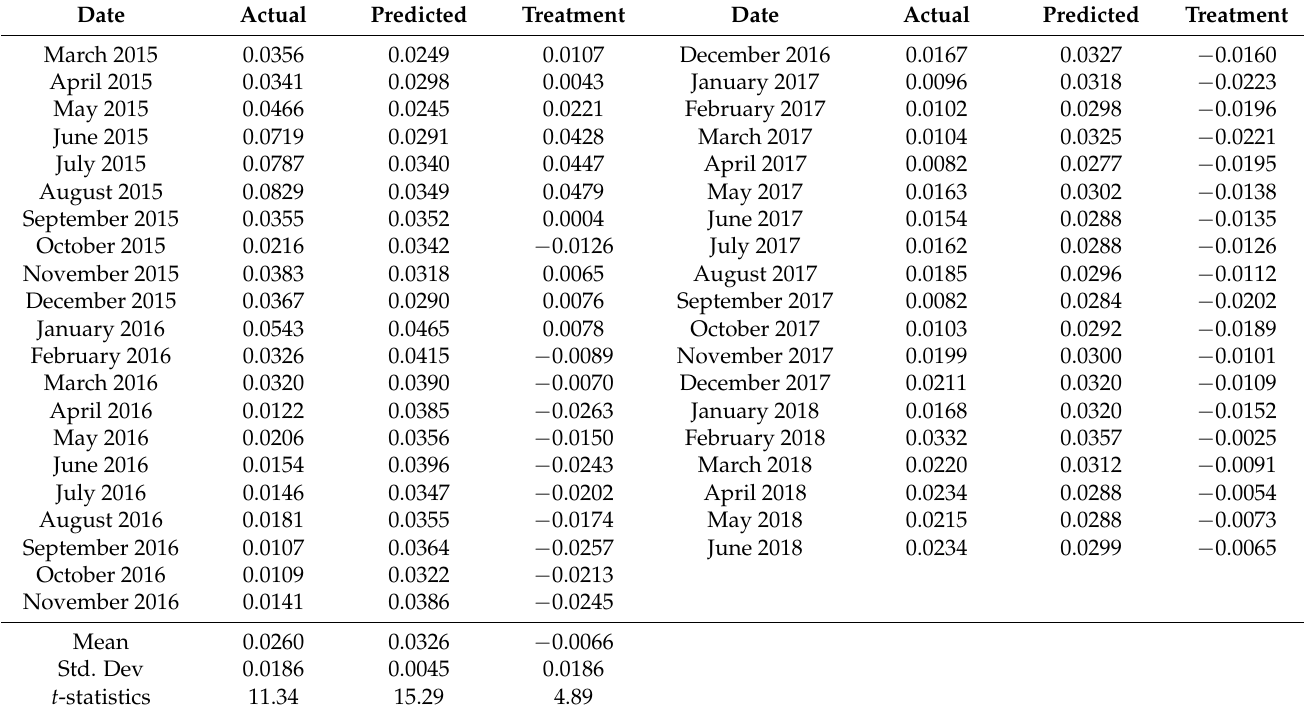
Table 3. Monthly treatment effect based on principal component